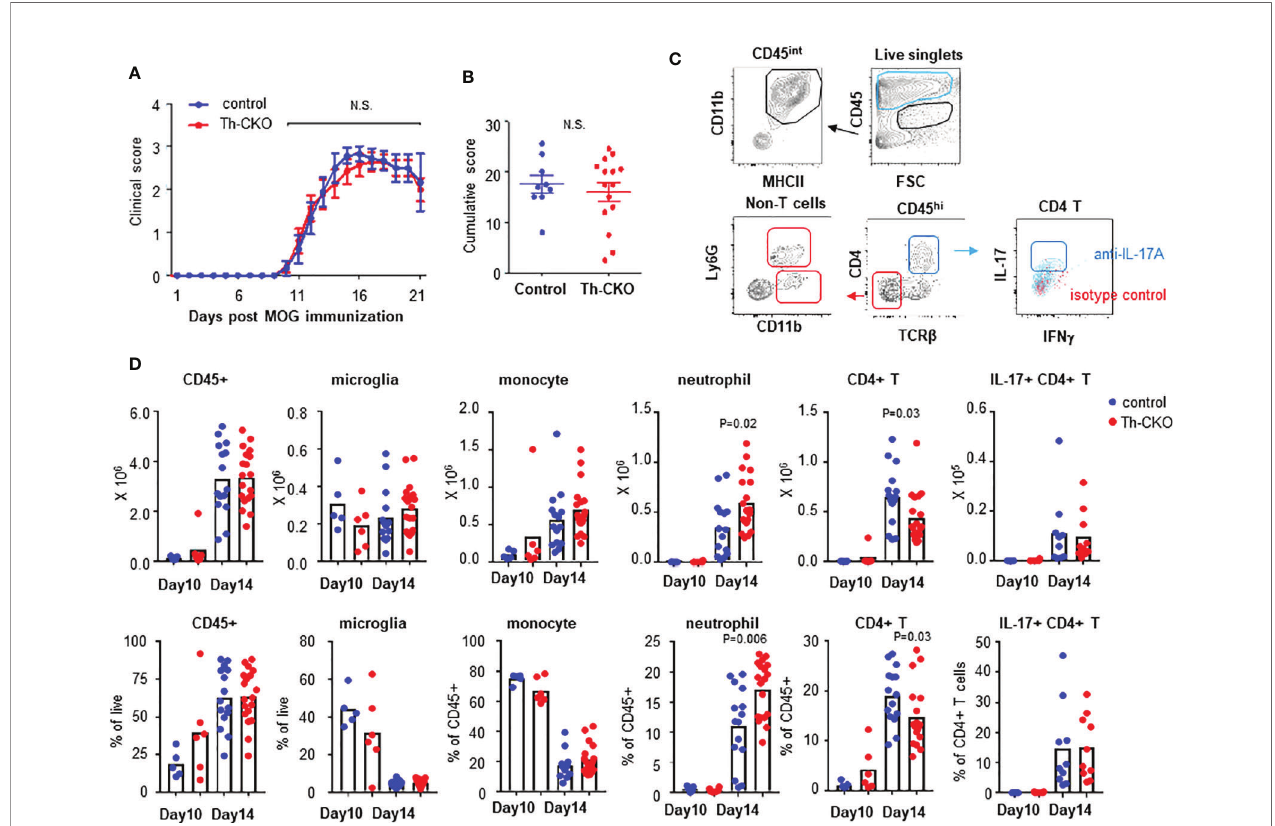
FIGURE 6 | EAE induction and in fi ltration of leukocytes in CNS in control and Th-CKO mice. EAE was induced by immunization with MOG peptide in CFA followed by Pertussis toxin injection in 10-12 weeks old female control and Th-CKO mice and disease severity was daily determined throughout the time-course of disease development. Daily clinical score (A) and accumulative score from individual mouse (B) was calculated. Values represent mean ± SEM with n = 9-15 mice per group. Mice were sacri fi ced at day 10 or day 14 post immunization and spinal cord was harvested to investigate in fi ltrating leukocytes. (C) A representative image of fl ow images. (D) Number (upper row) and frequency (bottom row) of each leukocyte subset were calculated in spinal cords. Blur dot represents the cells from control mice and red dot represents the cells from Th-CKO mice. Each dot represents an individual mouse and the bar represents the mean (n = 3). N.S., not signi fi